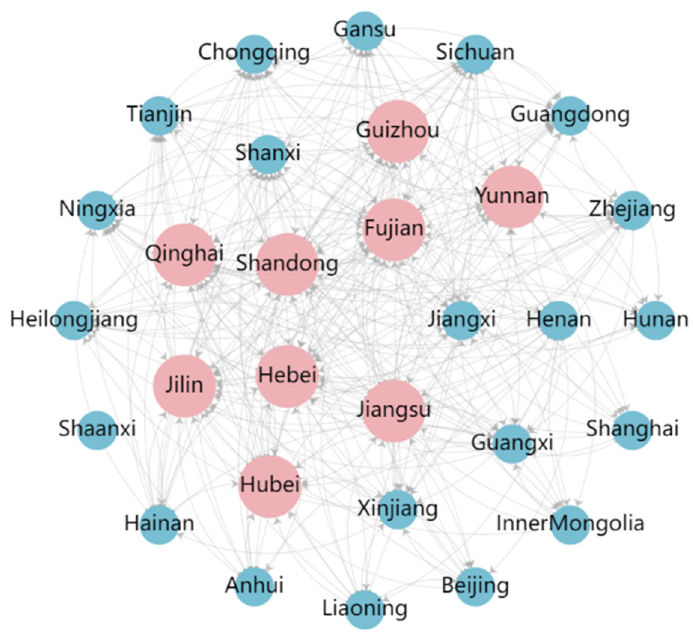
Figure 6. Network diagram corresponding to point centrality.